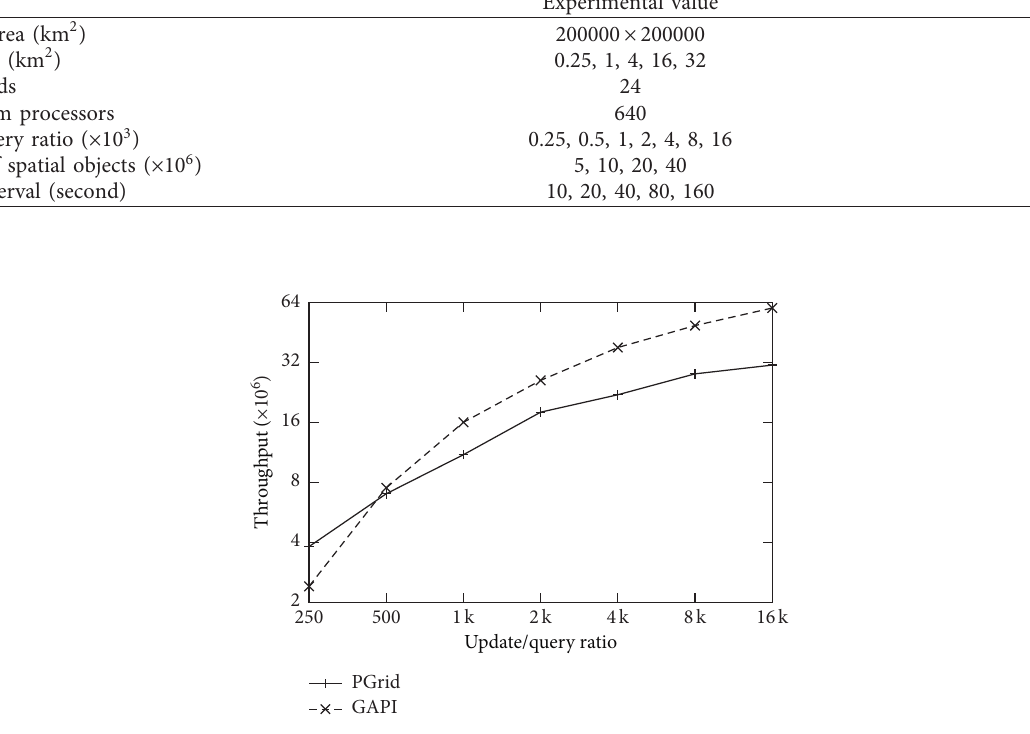
Figure 3: The effect of throughput on update/query ratio.